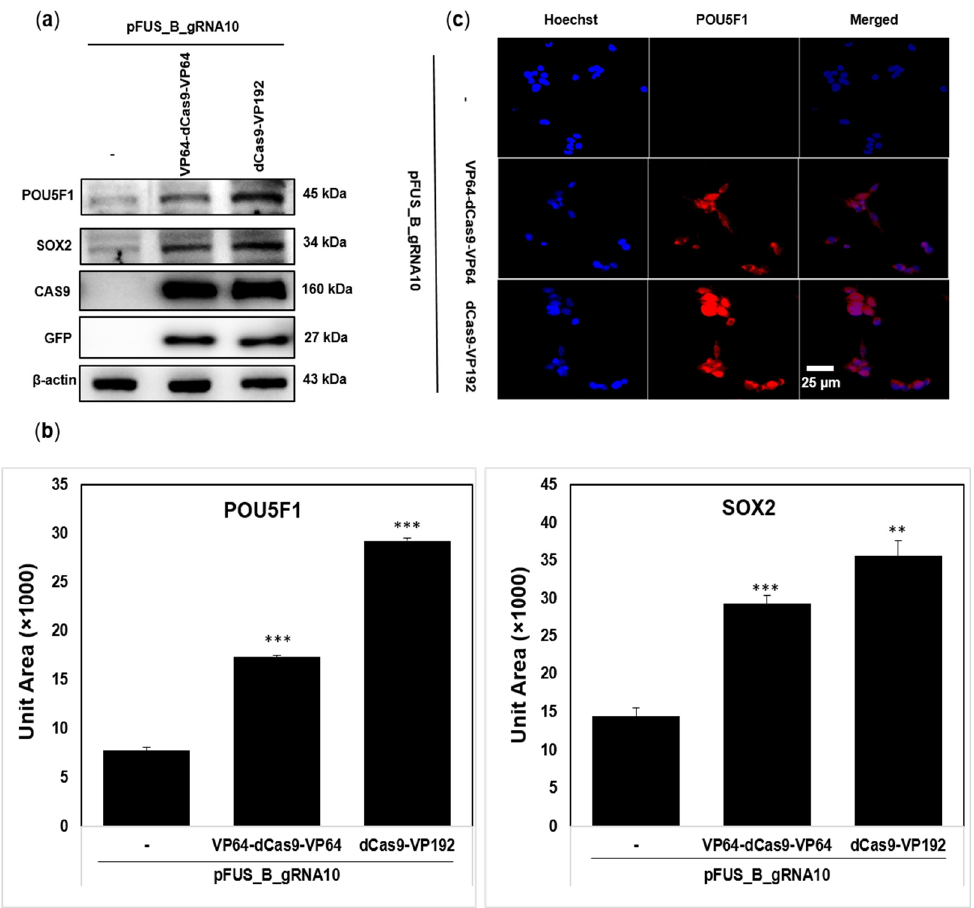
Figure 3. Regulation of the POU5F1 and SOX2 protein expression by CRISPR activators. ( a ) After 72 h of transfection with pFUS_B_gRNA10 alone or in combination with VP64-dCas9-VP64 or dCas9-VP192, the total cell proteins were isolated, separated, transferred, and immunoblotted with the relevant antibodies, as shown in the image. β -Actin served as a loading control. ( b ) Quantification of POU5F1 and SOX2 was conducted on the basis of their band intensities in the Western blot by using the ImageJ software. The absolute quantification values are the means of three independent measurements of their respective band intensities, represented in the form of unit area. The statistical comparison was carried out between cotransfected and single-plasmid-transfected values, where bars represent ± SEM (* p < 0.05, ** p < 0.01, *** p < 0.001) by Tukey’s method and one-way ANOVA. ( c ) The transfected cells were subjected to immunostaining and fluorescence microscopy after 72 h of transfection. The images were captured with an inverted microscope (Olympus IX53), where a blue color corresponds to nuclei stained with Hoechst 33,258 while the red color represents the POU5F1 protein. Scale bar, 25 μ m.